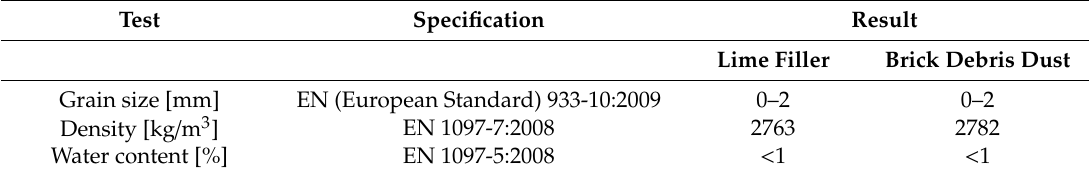
Table 1. Physical properties of lime filler and brick debris dust used in the